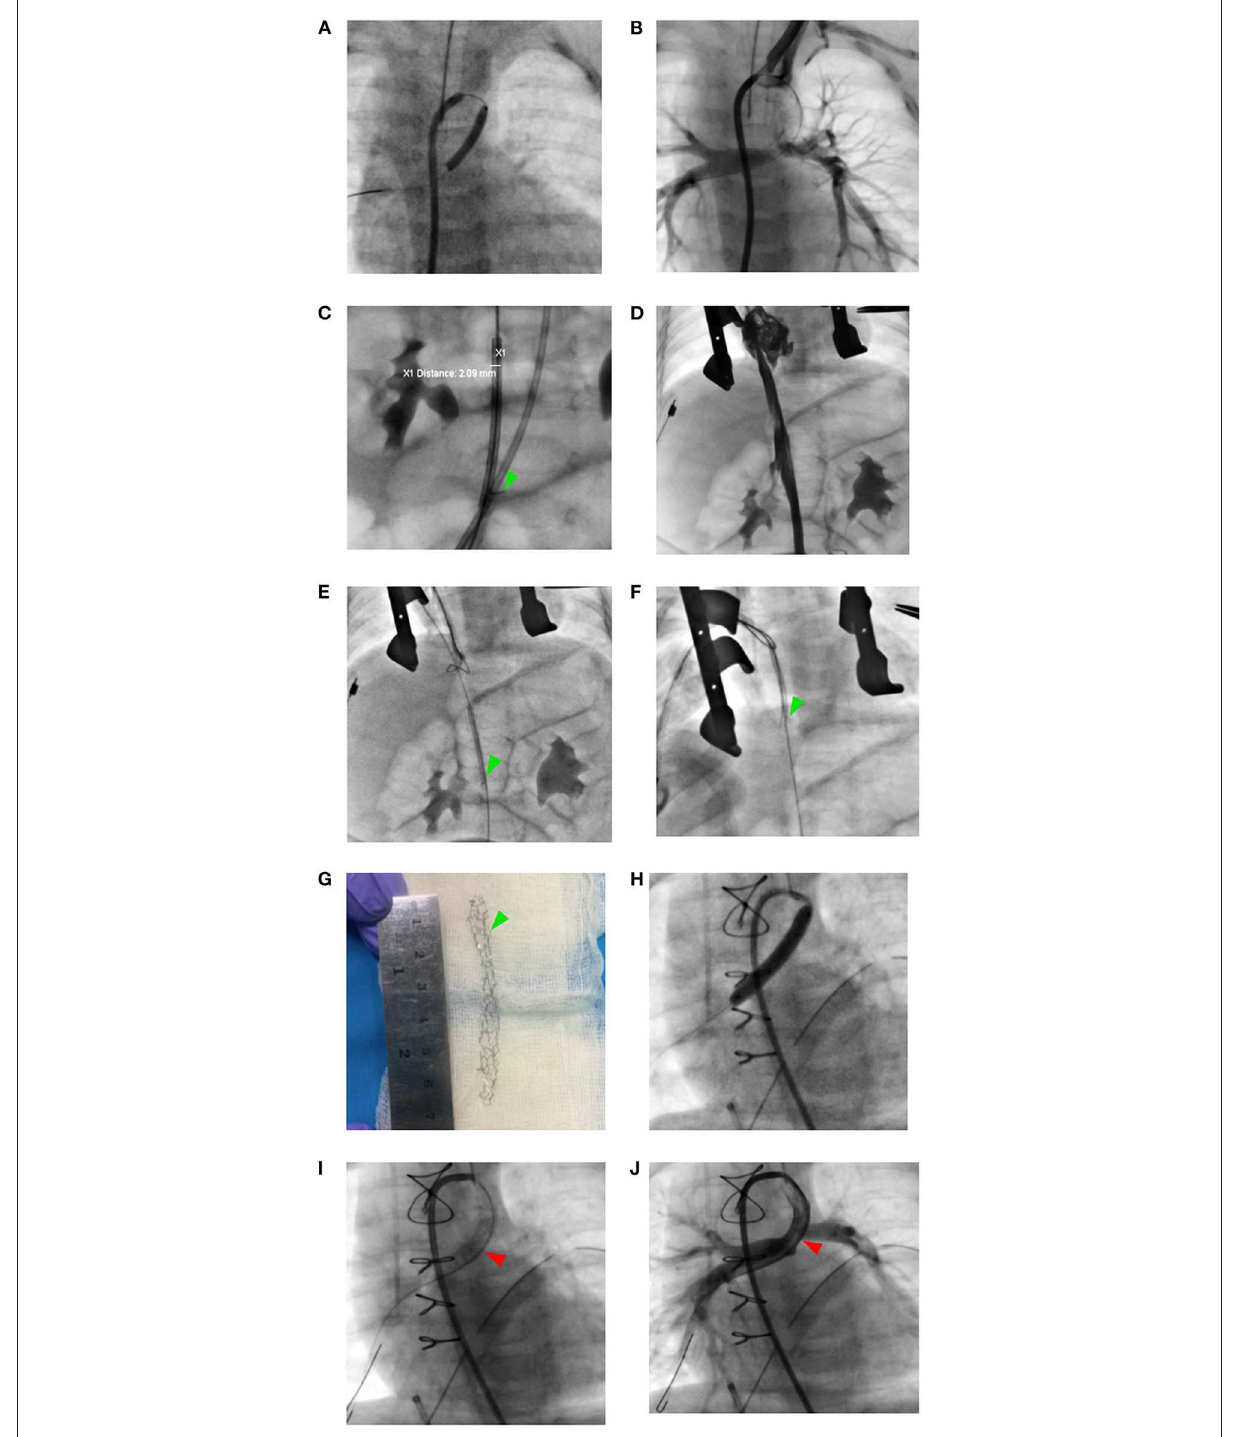
FIGURE2 Stucked stent retrival strategy from the inferior vena cava and transarterial restenting the ductus arteriosus. (A) Ductal pre-dilation with an Ikazuchi coronary balloon 3.0 x 20mm. (B) Failure to deliver the Dynamic vascular stent within the ductus arteriosus. (C) The stent strutted in the inferior vena cava (green arrowhead). (D) Caval angiography showing no vascular trauma. (E–G) Stent Evacuated through right atrial appendage hybrid access with 20mm gooseneck snare. (H, I) Transarterial ductal restenting with Resolute Integrity 4.0 x 30mm stent (red arrowhead). (J) Post-stenting ductal